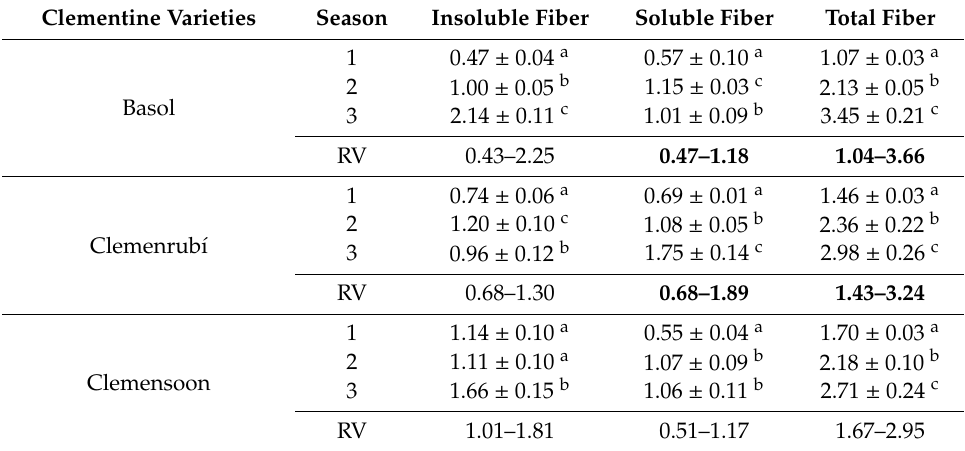
Figure 1. Proximate composition of extra early clementine varieties. Di ff erent letters in each column indicate statistically significant di ff erences ( p < 0.05) between seasons for each variety. Table 2. Dietary fiber composition (g / 100 g fw of the fruit edible portion) of extra early clementine varieties. Clementine